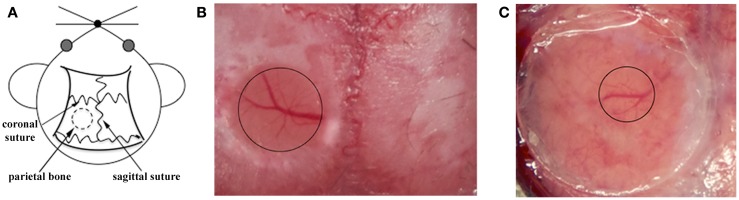
Surgical procedures for TPLSM imaging of the brain cortex: thinned skull preparation and open cranial window. (A) For both procedures, a circular area of parietal bone is shaved with an electric razor and the scalp is sterilized with alcohol. The head of the anesthetized mouse is then fixed on a stereotaxic device to reduce movement artifacts during imaging, and the skull overlying the cortical region is exposed. (B) For the thinned skull preparation, a small region on the parietal zone of the skull is thinned using a high-speed micro drill and a stainless steel burr until the cortical vasculature can be seen clearly through the thinned skull. The thinned area is enclosed by the black circle. (C) For the open cranial window technique, a small island of cranial bone on the parietal region (black circle) is drilled, removed with a pair of sharp forceps, and covered with a circular glass coverslip.